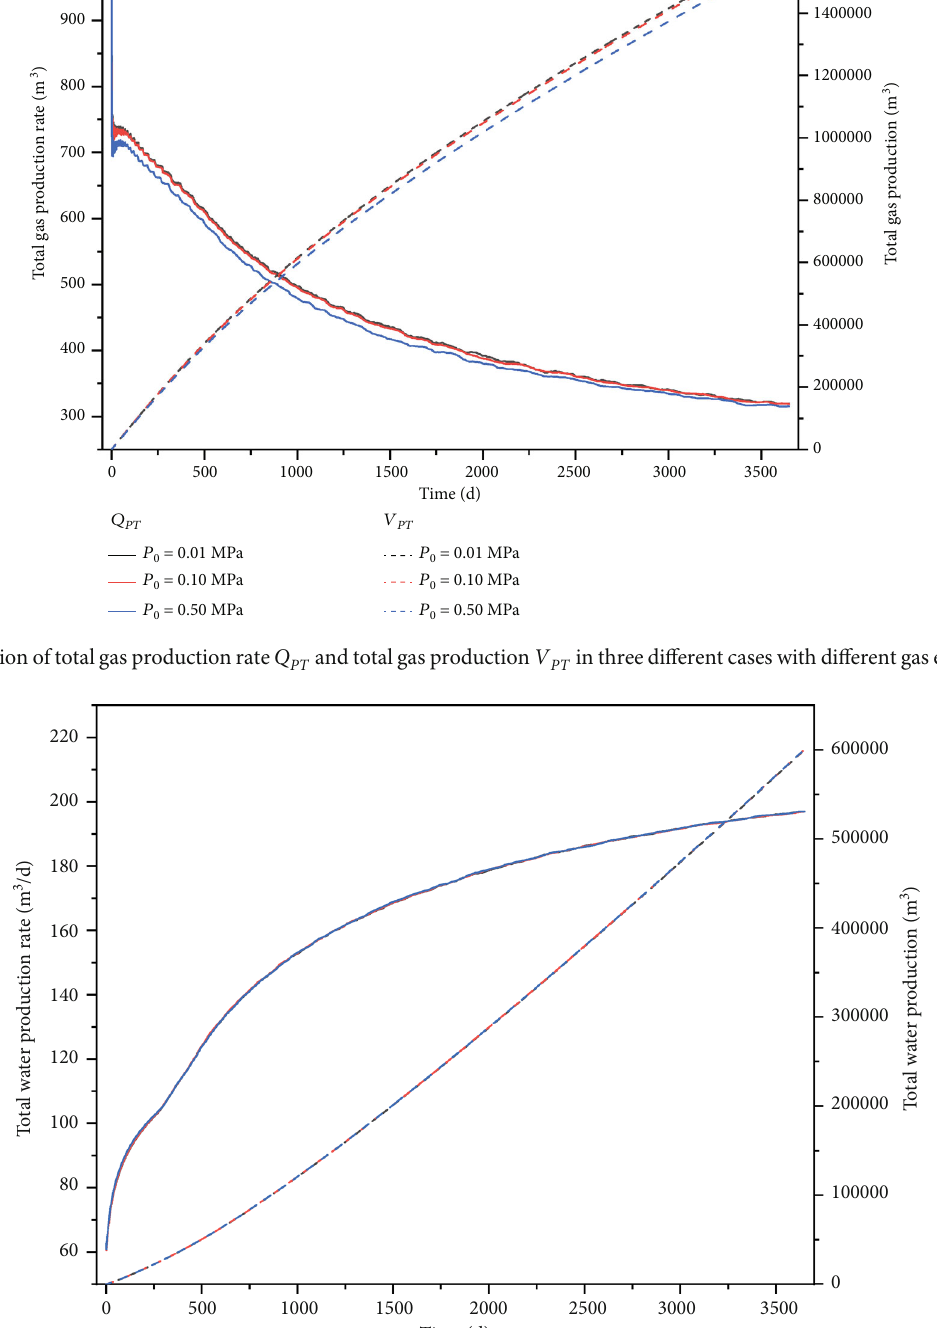
and total water production V W